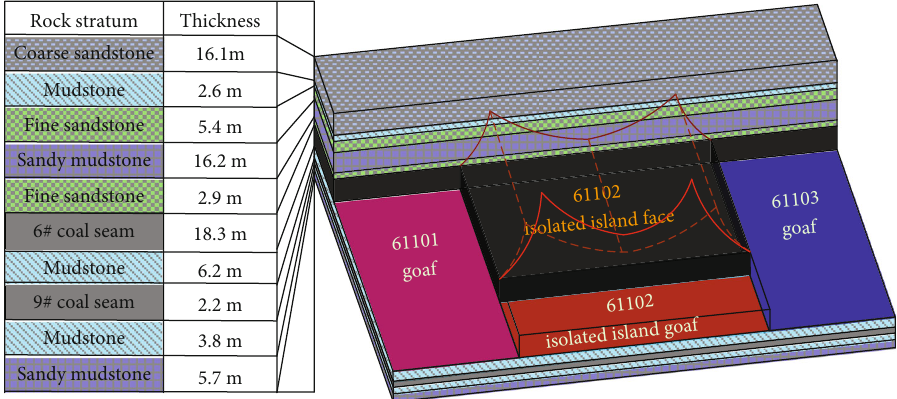
Figure 1: Space arrangement and rock occurrence conditions of the isolated coal face in fully mechanized caving